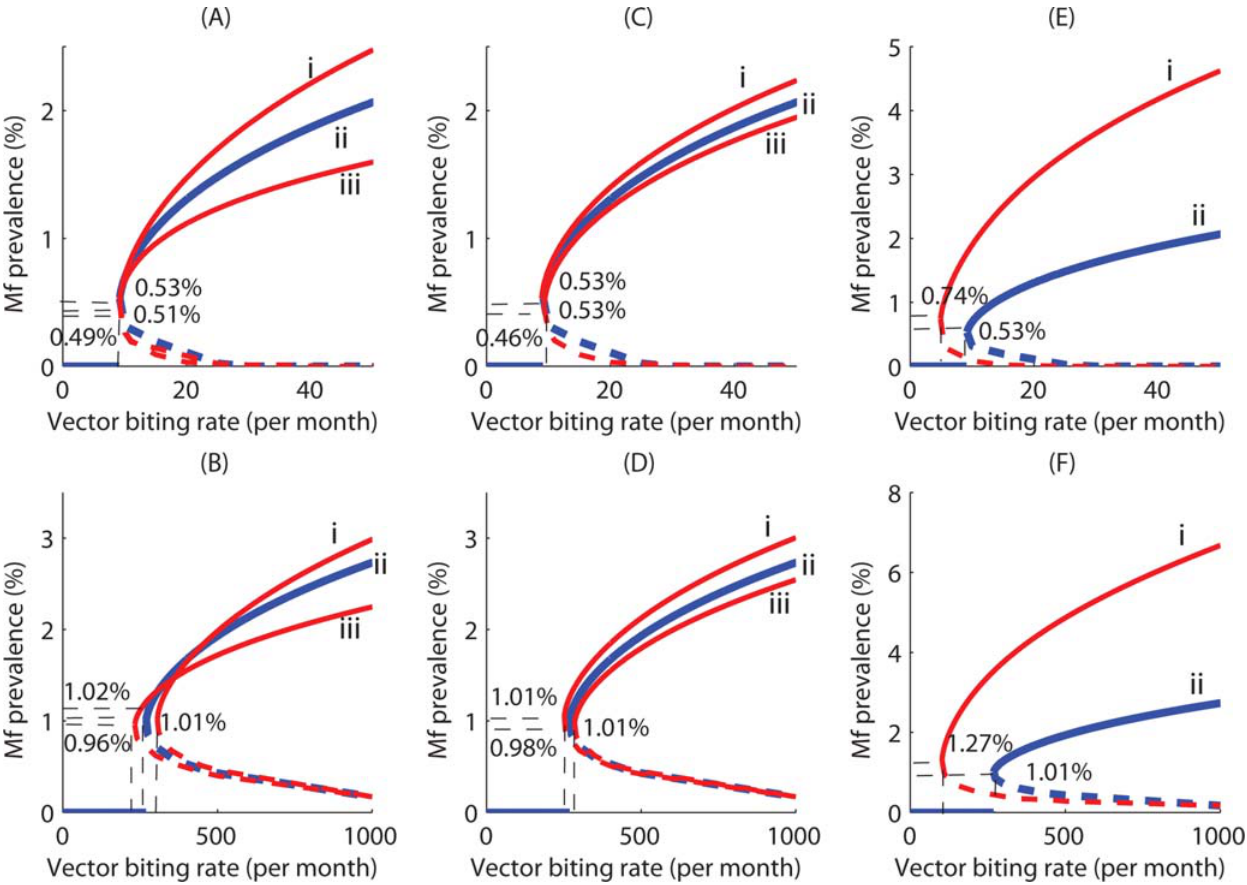
Figure 5. Sensitivity of the endemic Mf prevalence, breakpoint values, and TBRs to changes in the shape parameter of the negative binomial distribution, ( k ) describing the distribution of Mf among human hosts ((A) and (B)), the strength of the immune response to infection, b ((C) and (D)), and per capita worm fecundity, a ((E) and (F)). The k values were varied by maintaining the linear dependence upon Mf values (see text) but increasing/decreasing the linear component by 50% so that this value was given by i) 0.0354, ii) 0.0236, and iii) 0.0118. When the intermediate host was (A) culicine, the maximum value of the breakpoint changed with k , but the TBR (units are bites per month) did not change (TBR=9). For anopheline intermediate hosts (B), both the maximum breakpoint and the TBR decreased with decreasing k (TBR=i) 306, ii) 271, iii) 233)). The parameter b can be thought of as an index governing the strength of the density dependent establishment of parasites in the human hosts. The b values were varied by 10% so that the values used here were: i) 0.1, ii) 0.112, and iii) 0.122. When the intermediate host was (C) culicine, the maximum value of the breakpoint changed with b , but the TBR did not change from its value of 9. For anopheline intermediate hosts (D), the maximum breakpoint decreased and the TBR increased with increasing b (decreasing density dependence) (TBR=i) 252, ii) 271, iii) 285)). Graphs (E) and (F) depict the steady state Mf prevalence values found for values of per capita worm fecundity, a , of either i) 0.4 or ii) 0.2. When the intermediate host was either (E) culicine or (F) anopheline, the maximum value of the breakpoint rose and the TBR was lowered with increasing a (TBR (E) Culex : i) 5, ii) 9; (F) Anopheles : i) 104, ii) 271)).